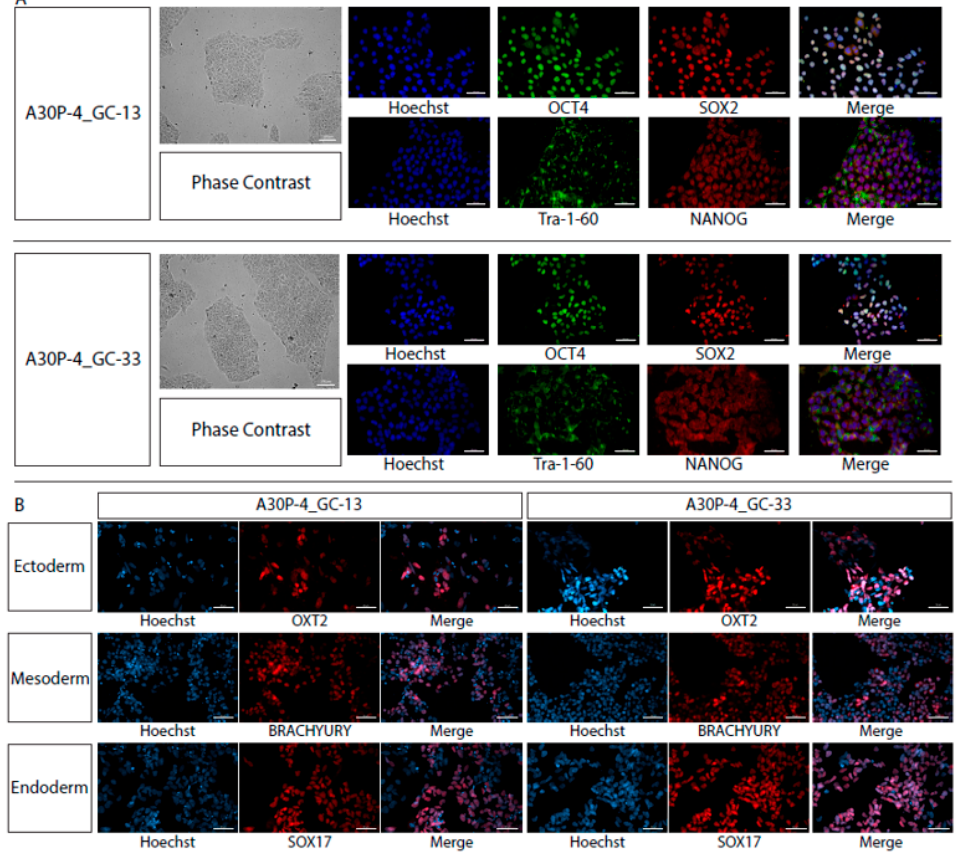
Figure 5. iPS cell line characterization. ( A ) Pluripotency characterization of the three single-cell isogenic lines generated in this project. Phase contrast images of pluripotent colonies, image taken using a 5 × objective. Scale bar represents 100 µ M. Antibody specific pluripotency marker expression of OCT4 / SOX2 and NANOG / TRA-1-60. Images taken using a 25 × objective, scale bar is 50 µ M. ( B ) Directed di ff erentiation to the three embryonic germ layers using antibodies specific to the ectoderm (OTX2), endoderm (SOX17) and mesoderm (BRACHYURY). Images taken using a 25 × objective, scale bar is 50 µ